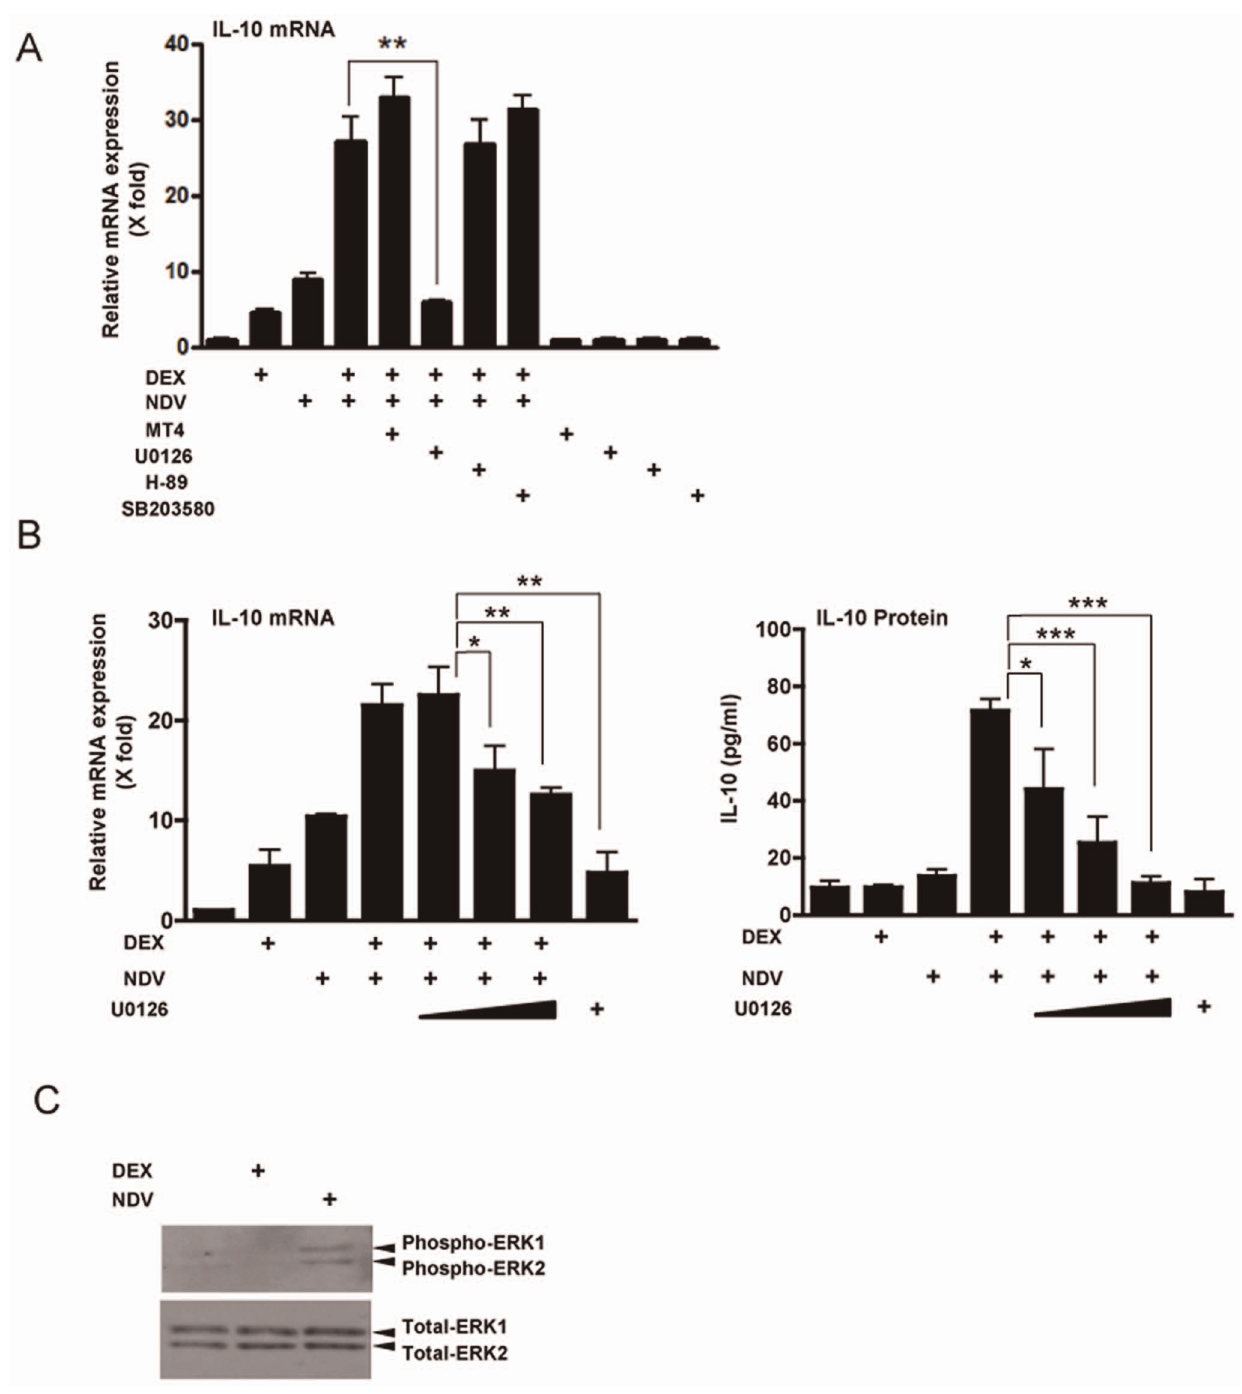
Figure 6. ERK1/2 mediated DEX- and NDV-induced cooperative IL-10 mRNA expression in DCs. A. ERK inhibitor U0126 abolished DEX- and NDV-induced cooperative IL-10 mRNA expression in DCs. DCs were pre-treated with indicated kinase inhibitors for 30 min (p38 MAPK inhibitors SB203850 (1 m M) and MT4 (10 m M); the ERK inhibitor U0126 (0.1 M); and the PKA inhibitor H-89 (12.5 nM)). They were then treated with DEX (10 2 6 M) for 30 min, and were infected with NDV (MOI=10) for 6 hours. **: p , 0.01, compared the 2 conditions indicated. B. ERK inhibitor U0126 dose- dependently reduced DEX-and NDV-induced cooperative IL-10 mRNA and protein expression in DCs. DCs were pre-treated with increasing concentrations of U0126 (0.1 M, 1 M and 10 M), and were treated with DEX (10 2 6 M) for 30 min. They were then infected with NDV (MOI=10) for 6 hours. Bars represent means and standard errors of fold changes of the IL-10 mRNA (left panel) and protein concentrations in culture media (right panel). *: p , 0.05, **: p , 0.01, ***: p , 0.001, compared to the 2 conditions indicated. C. NDV infection but not DEX pre-treatment activated ERK1/2 in DCs. DCs were treated with DEX (10 2 6 M), or were infected with NDV (MOI=10) for 6 hours. Whole cell extracts were obtained after 24 hours of infection, and were run on SDS-PAGE gels. Phosphorylated ERK1/2 and their entire fraction were visualized with their specific antibodies in Western blots.